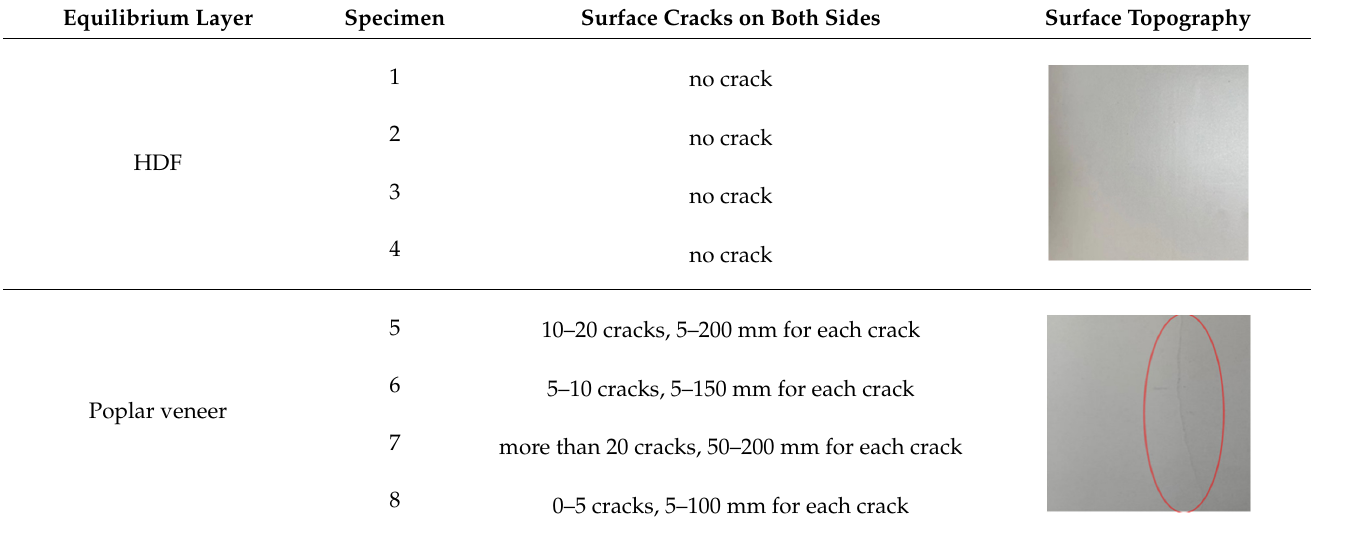
Table 1. Surface cracking resistance of ecological board prepared with different equilibrium layers.